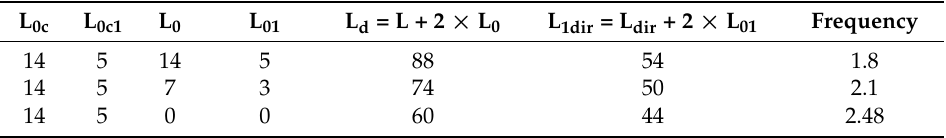
Figure 4. Simulated 3-D radiation pattern of final antenna design at: ( a ) 1.87 GHz; ( b ) 2.1 GHz; and ( c ) 2.48 GHz. Table 1. Dimensions of channels and liquid metal corresponding to each frequency.